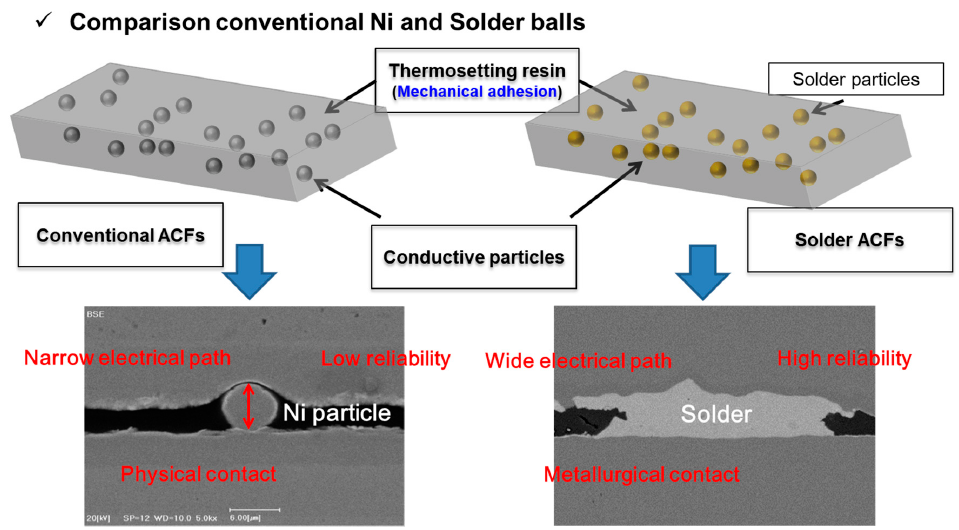
Figure 2. A comparison of the conventional Ni and Sn solder metallurgical anisotropic conductive films (ACFs) joints.